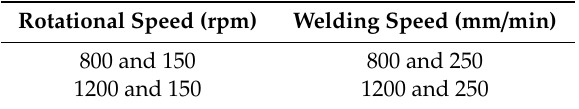
Table 2. Welding parameters used for di ff erent FSW lap